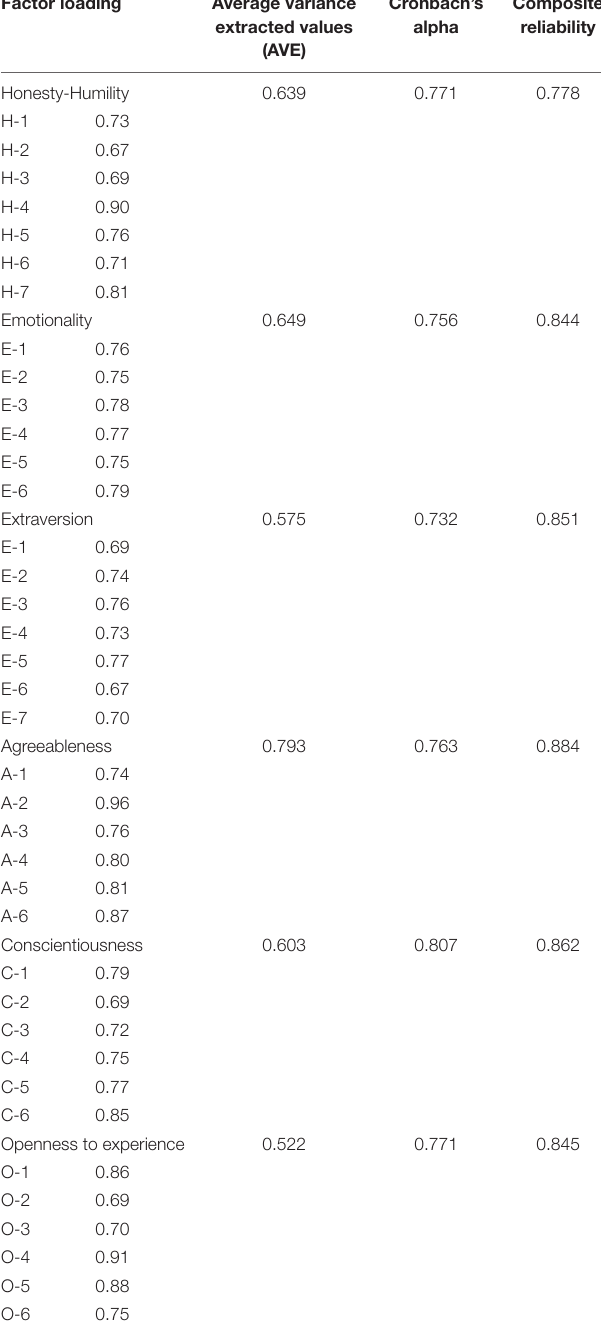
TABLE 1 | Measurement